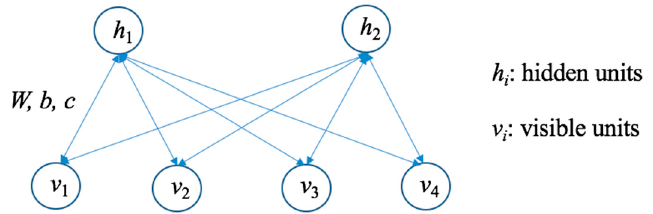
Figure 1. The illustration of a Restricted Boltzmann Machine (RBM) with two hidden units and four visible units.